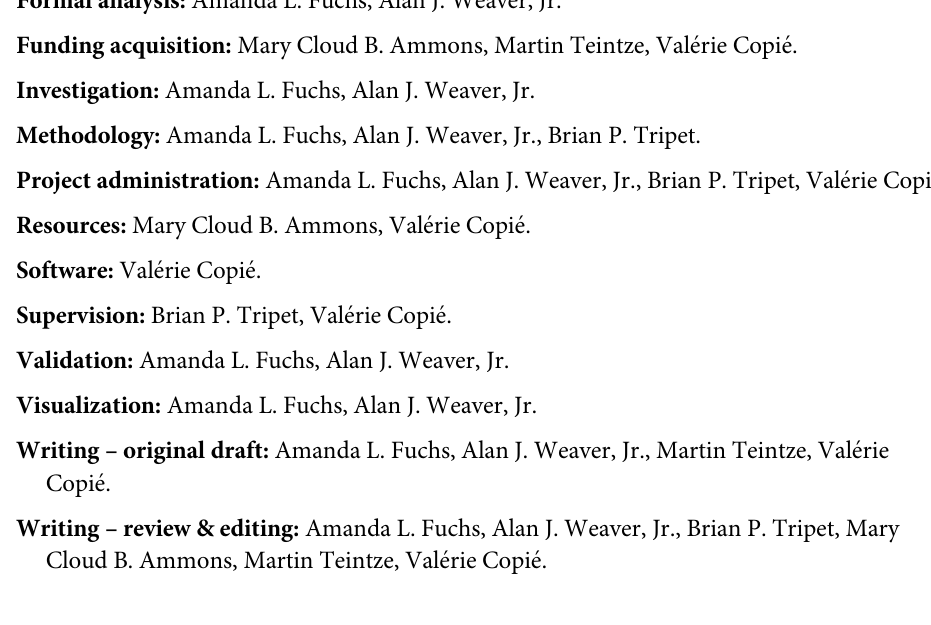
S3 Fig. Allicin structure and 1 H NMR spectral data. The molecular structure of allicin is shown in (A). Assignments, chemical shifts ( δ , ppm), relative integrated intensities, multiplici- ties, and coupling constants (J, Hz) from 1 H NMR spectra are displayed for (B) an allicin stan- dard and (C) allicin in ES-GBBr formulation SM-NP fraction. S1 Table. pH and ethanol % v/v of Bald’s eyesalve formulations.